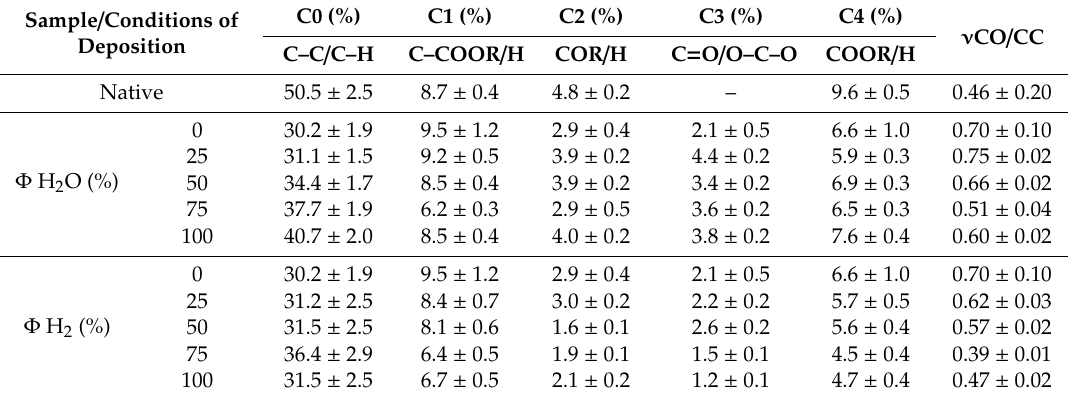
Figure 3. Variation of the X Mg / MgO ratio resulting from the curve-fitting of the XPS high-resolution Mg 2p spectra as a function of the gas feed composition for plasma-processed PCL flat samples. Note: • = H 2 O; o = H 2 . Table 3. Curve-fitting results of the high-resolution XPS C 1s spectra of native and plasma-modified PCL flat samples. The fraction of the O-containing groups ( ν CO) is reported as the sum of the C1, C2, C3, and C4 percentages.